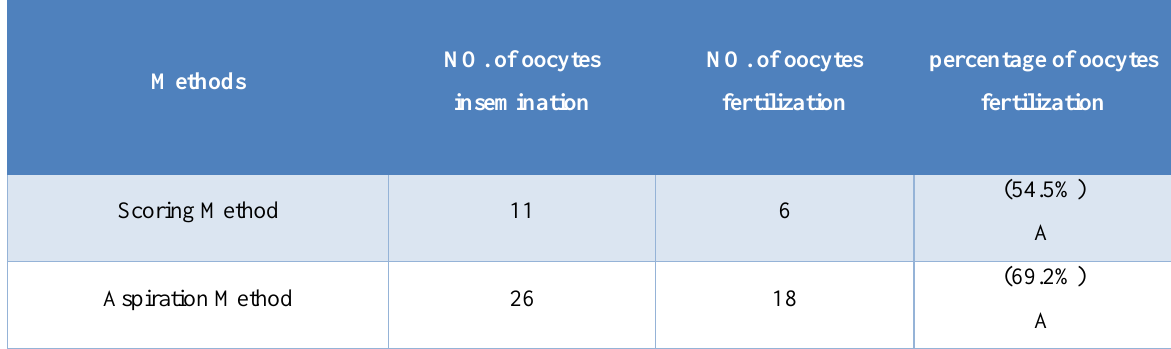
Aspiration Method 32 *Different small letters vertically denote significant (P<0.05) between methods of oocyte maturation(X=15.212). Table, 4: Effect of methods collection on In vitro fertilization (IVF) of oocytes maturation in different methods.